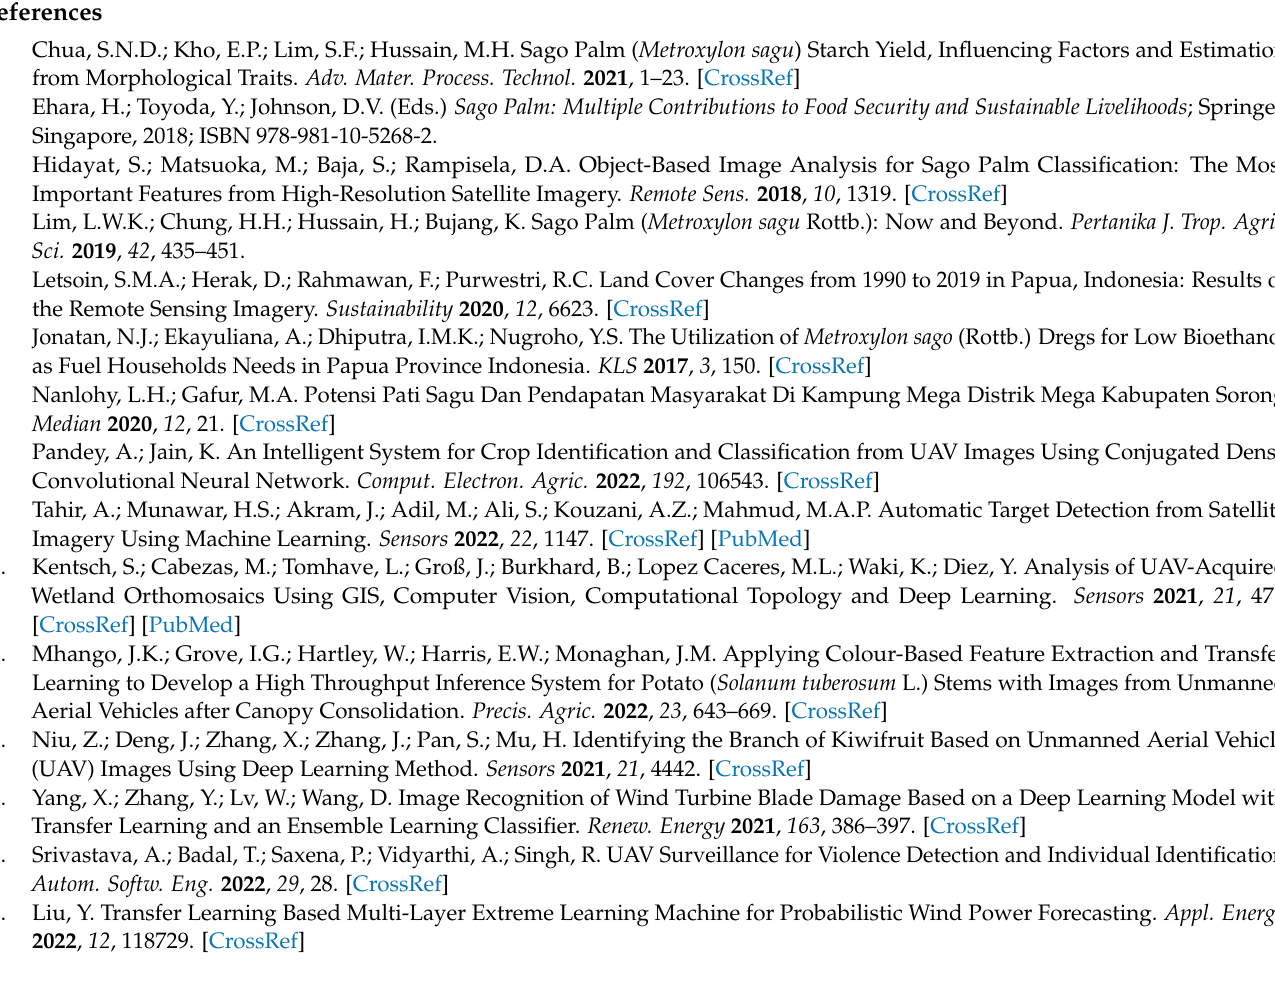
Figure A4. Model used: ResNet-50 network.